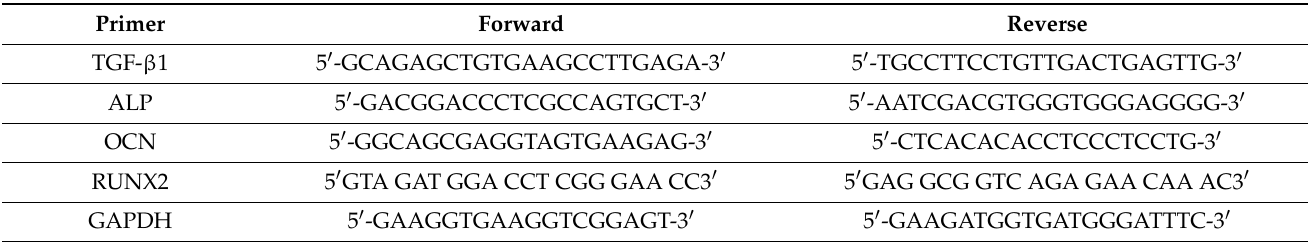
Table 1. List of primer sequences used in